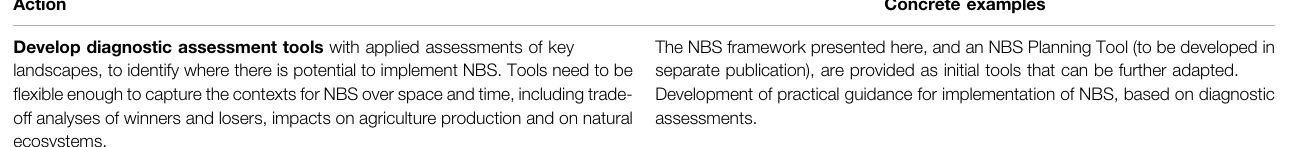
TABLE 3 | Categories of needed actions and possible concrete